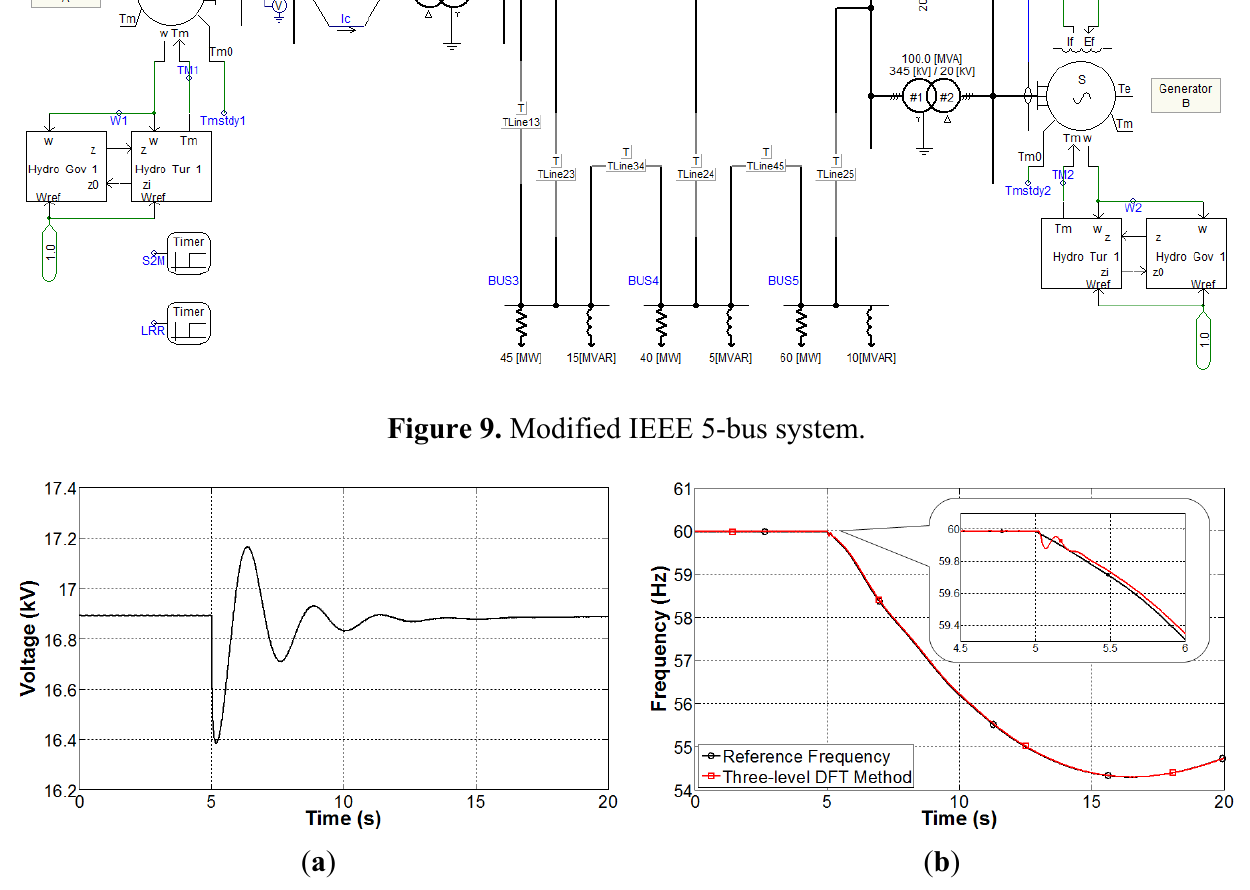
Figure 10. Estimation of the power system frequency when the total load increased by 20%. ( a ) Terminal voltage of generator A; ( b ) Estimated